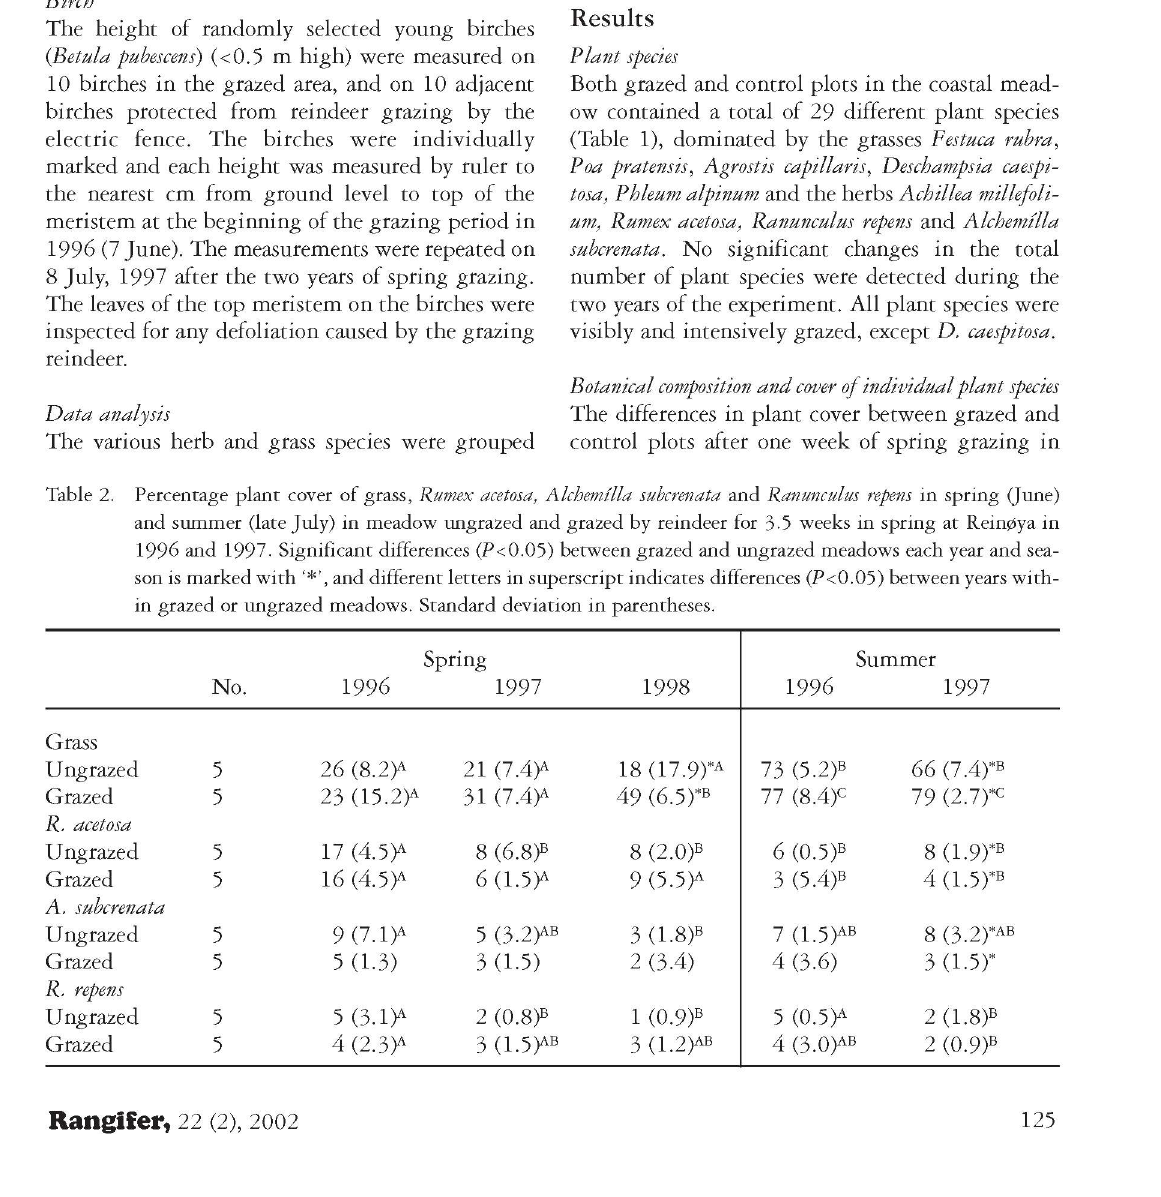
Table 2. Percentage plant cover of grass, Rumex acetosa, Alchemtlla subcrenata and Ranunculus repens in spring (June) and summer (late July) in meadow ungrazed and grazed by reindeer for 3.5 weeks in spring at Reinøya in 1996 and 1997. Significant differences (P<0.05) between grazed and ungrazed meadows each year and sea son is marked with '*', and different letters in superscript indicates differences (P<0.05) between years with in grazed or ungrazed meadows. Standard deviation in